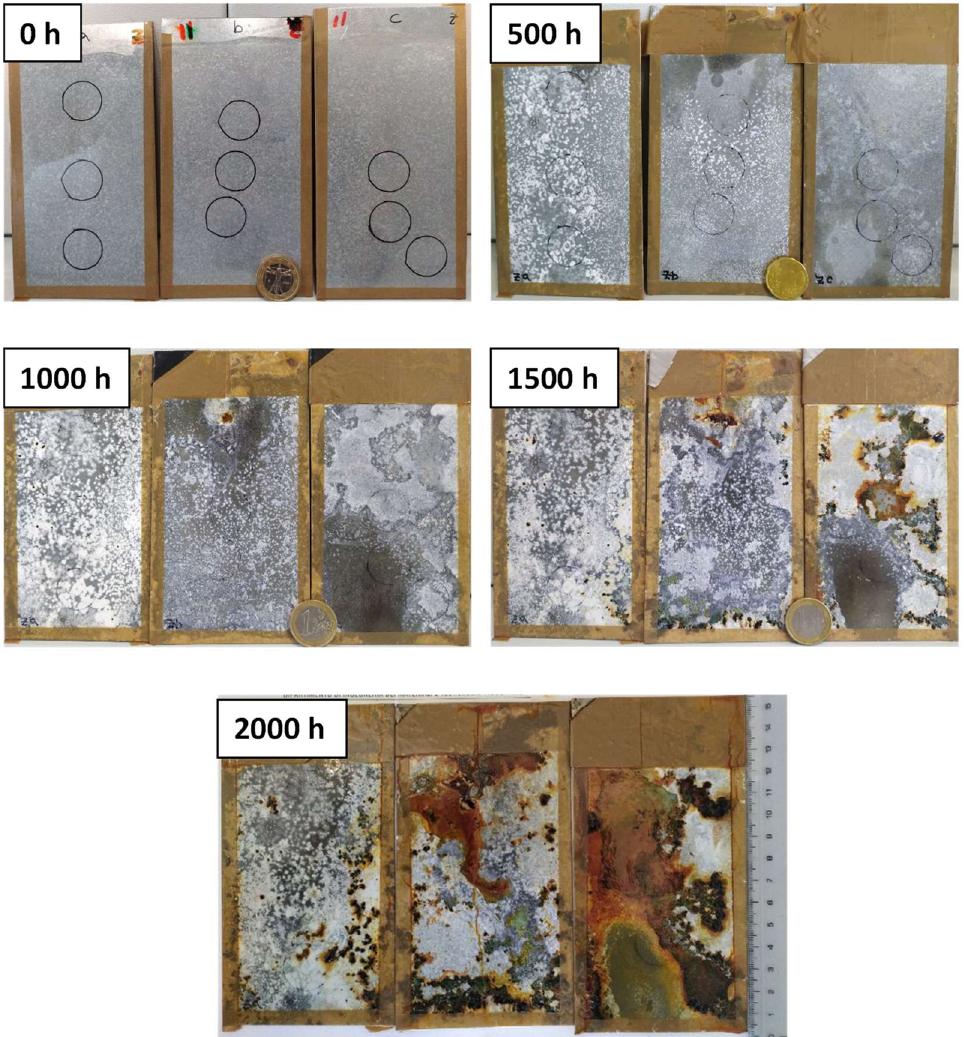
Figure 5. State of damage of painted HDG steel samples after 0, 500, 1000, 1500, and 2000 h of NSST.